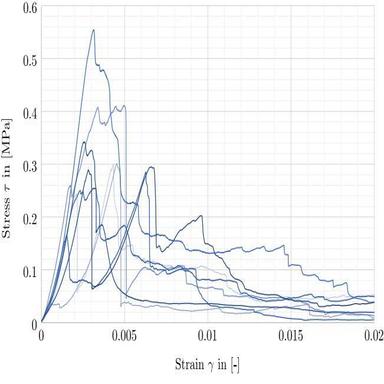
Triplet test shear stress–strain results.